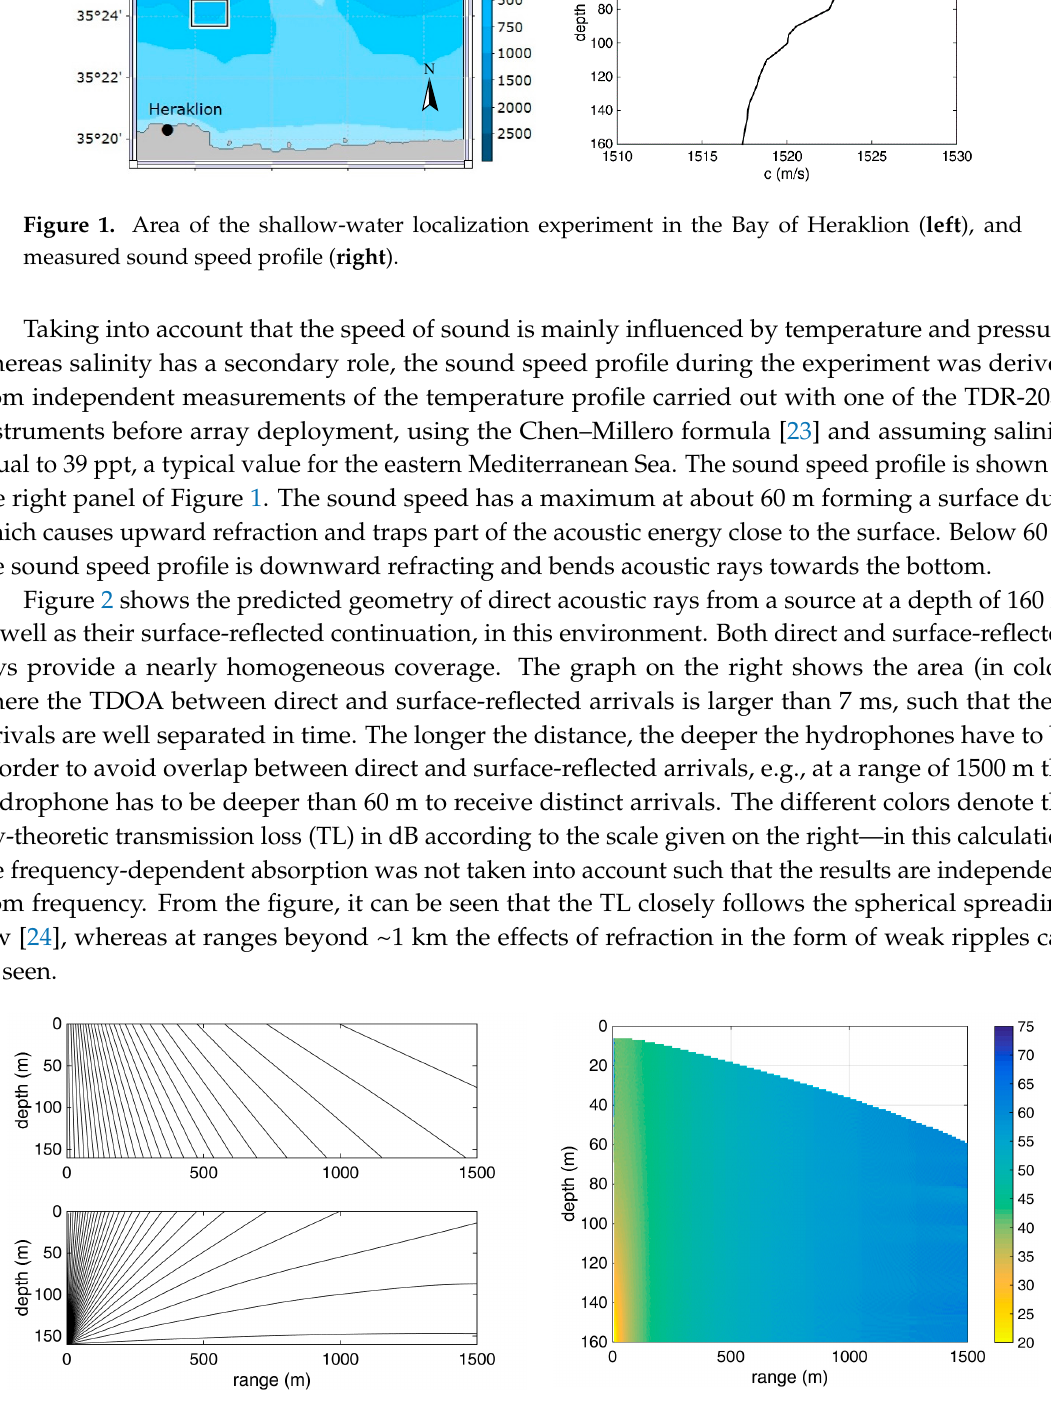
Figure 2. Predicted geometry of direct ( bottom left ) and surface-reflected ( top left ) acoustic rays from a source at a depth of 160 m in the sound speed profile of Figure 1. Area where the TDOA between direct and surface-reflected arrivals is larger than 7 ms ( right ). The colors in that area denote the ray-theoretic transmission loss (TL)—scale on the right in dB—without absorption.